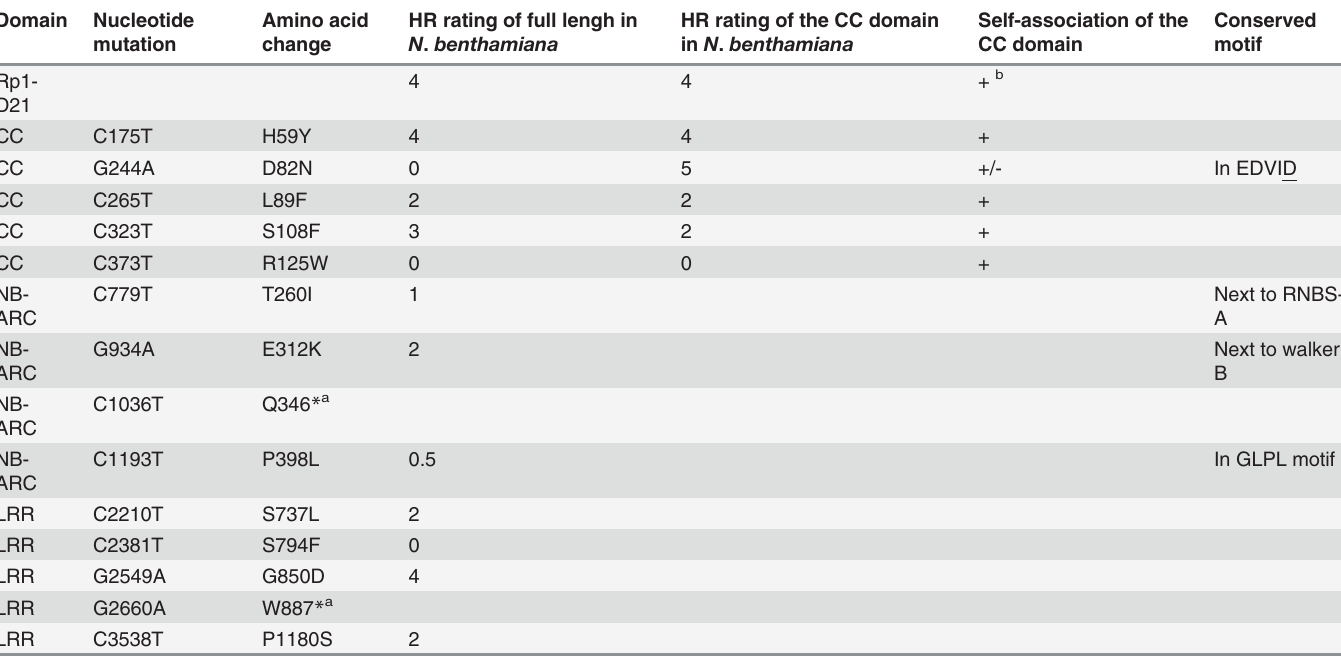
Table 1. Mutations that abrogated Rp1-D21 -induced HR identi fi ed in an EMS mutagenesis screen in maize. Domain Nucleotide